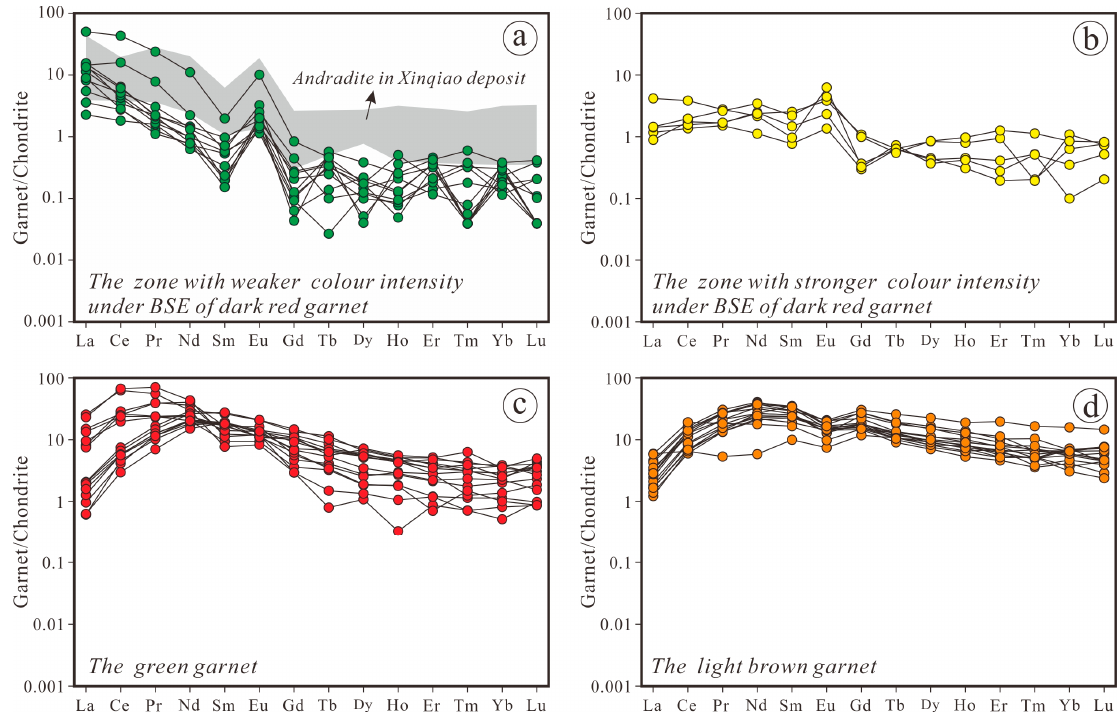
Figure 9. Chondrite-normalized REE patterns of garnets from Yongping. Samples were normalized to the C1 values of Sun and McDonough [65]. The field of Xinqiao andradite is from [64]. ( a ) Zone with stronger color intensity under BSE of dark red garnet; ( b ) zone with weaker color intensity under BSE of dark red garnet; ( c ) green garnet; ( d ) light brown garnet.